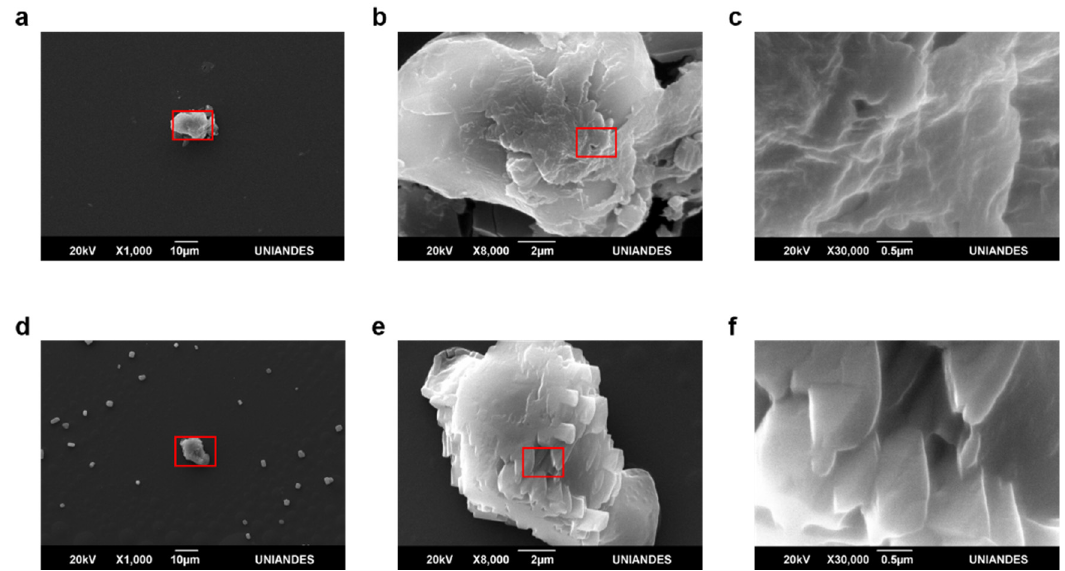
Figure 8. Scanning electron microscope (SEM) images of AC ‐ C prior to and after decolorization experiments. ( a ), ( b ), and ( c ) before decolorization of Congo Red. ( d ), ( e ), and ( f ) after decolorization of Congo Red. Surface morphology was considerably intricate and showed terrace ‐ like structures. Additionally, it exhibits deposits, which were explained by the formation of crystals upon dye degradation.